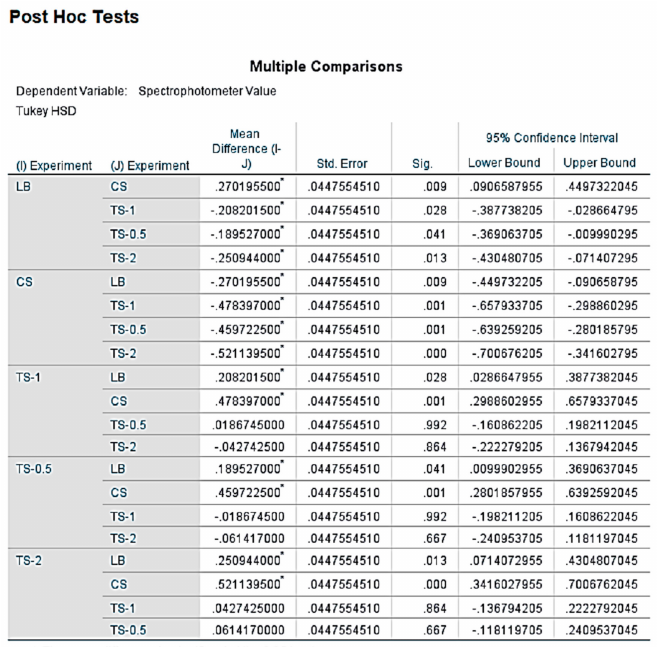
Figure 2. SPSS results using the one-way ANOVA and Tukey Post-Hoc tests revealed that exponential growth rate of samples treated with CS ( p = 0.006), TS-1 ( p = 0.005), TS-0.5 (0.018), and TS-2 (0.000) were significant in comparison to the sample exposed to only LB. There was a significant difference ( p < 0.05) in the exponential growth rates of TS-2 against TS-1 and TS-0.5. However, there was no significance between the EGR of TS-1 and